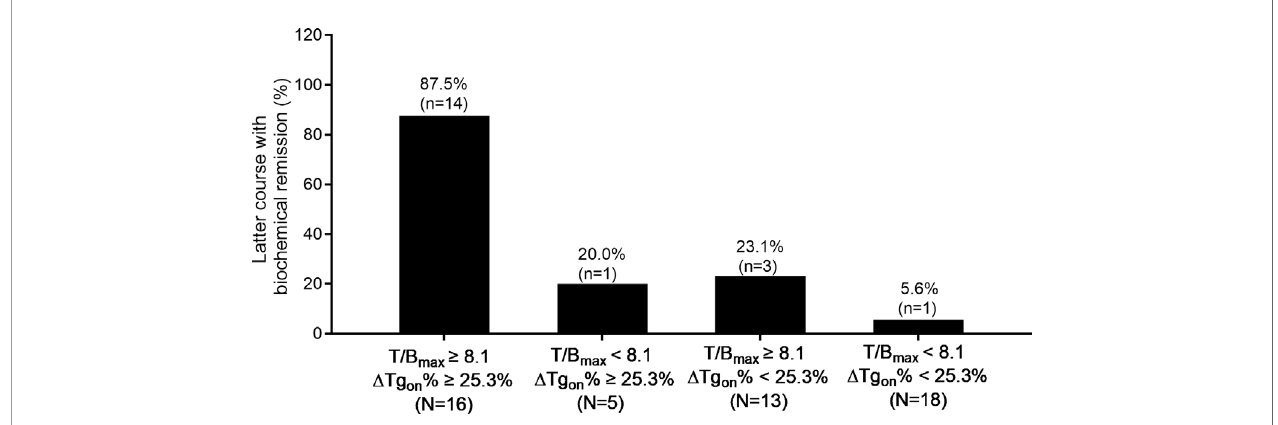
FIGURE 6 | Distribution of biochemical remission in 52 paired latter courses of RT in patients with accumulated 131 I activity ≥ 22.2 GBq with regard to the results of T/B max and D Tg on % obtained from the former courses. RT, radioiodine treatment; T/B max , maximum target-to-background ratio; Tg on , thyroid stimulating hormone- suppressed thyroglobulin; D Tg on %, change rate of Tg on